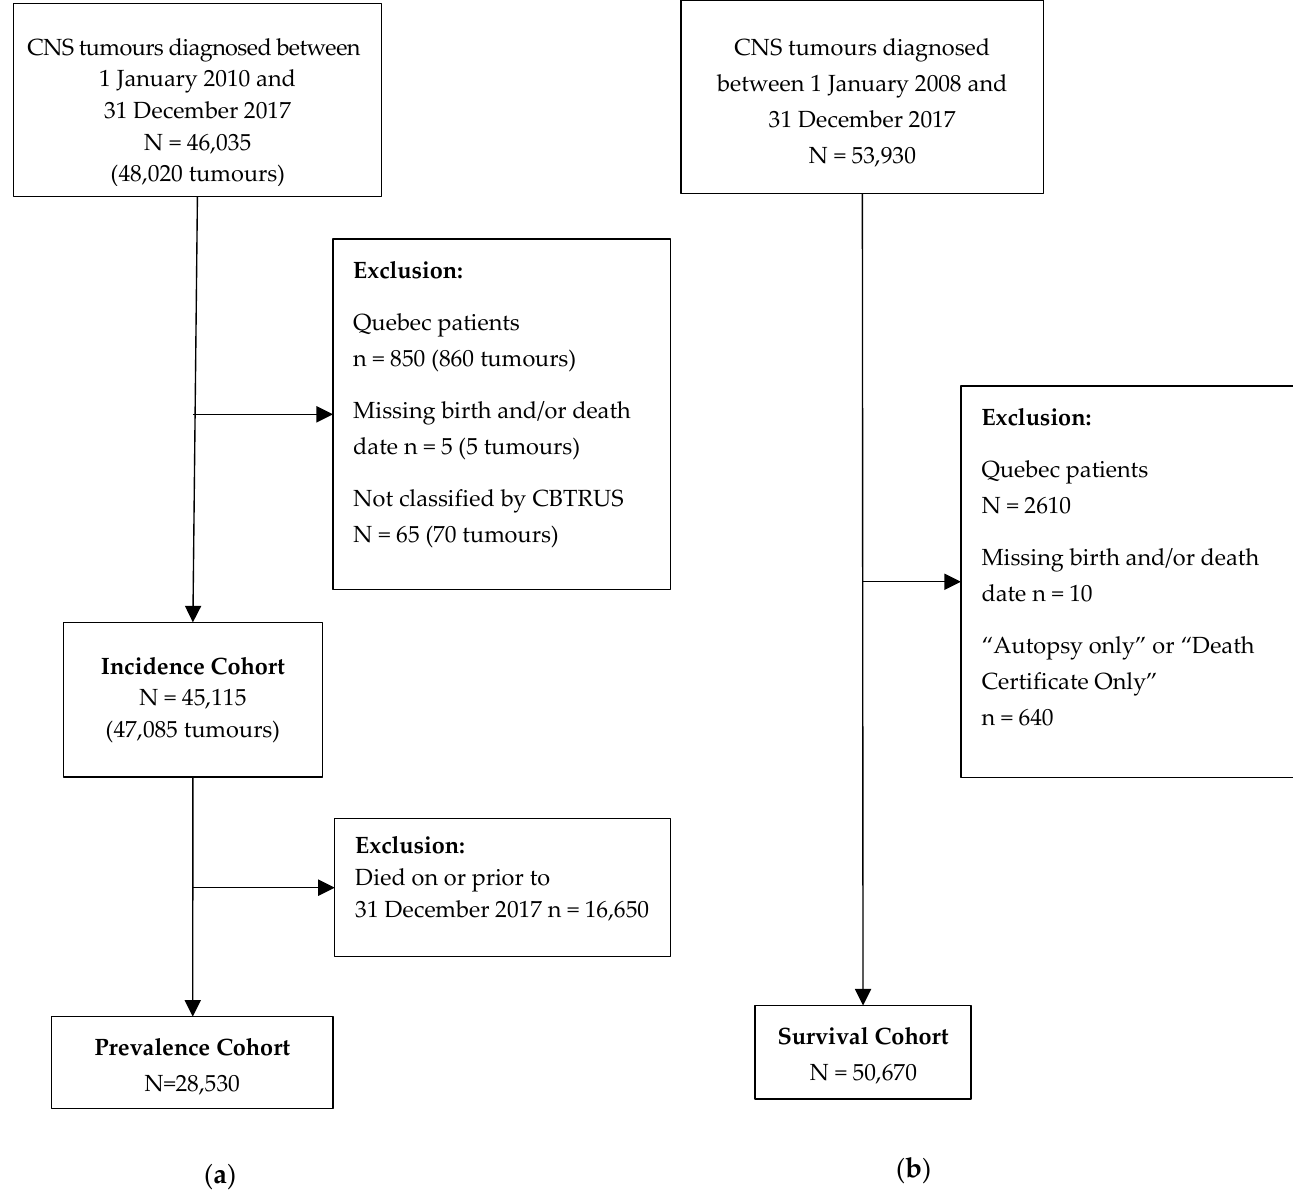
Figure 1. Study cohort flowchart for inclusion in the analyses. ( a ) The incidence and prevalence cohorts; ( b ) the survival cohort.